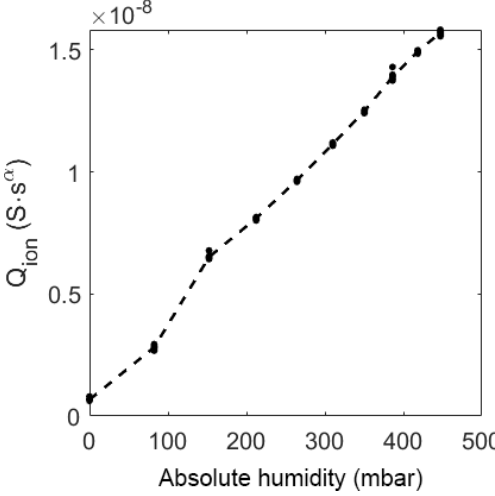
Figure 12. Prefactor of CPE ion over absolute humidity at 320 ◦ C. The dots represent the value of the fit of each measurement. The dashed line represents the mean of the dots.